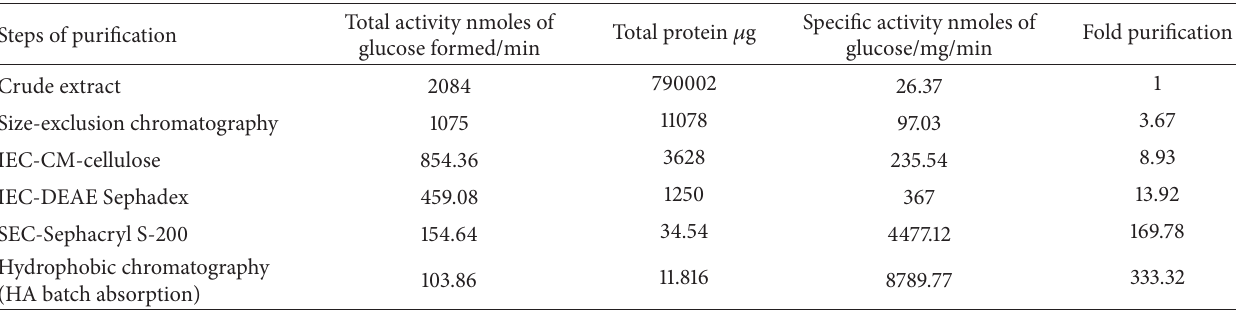
Table 1: Purification of intracellular sucrase: the table shows the list of different steps, taken during the purification process. The total enzyme activity, the amount of protein recovered, and the specific activity of the sucrase enzyme were estimated from each step of the purification procedure to calculate the increased fold of